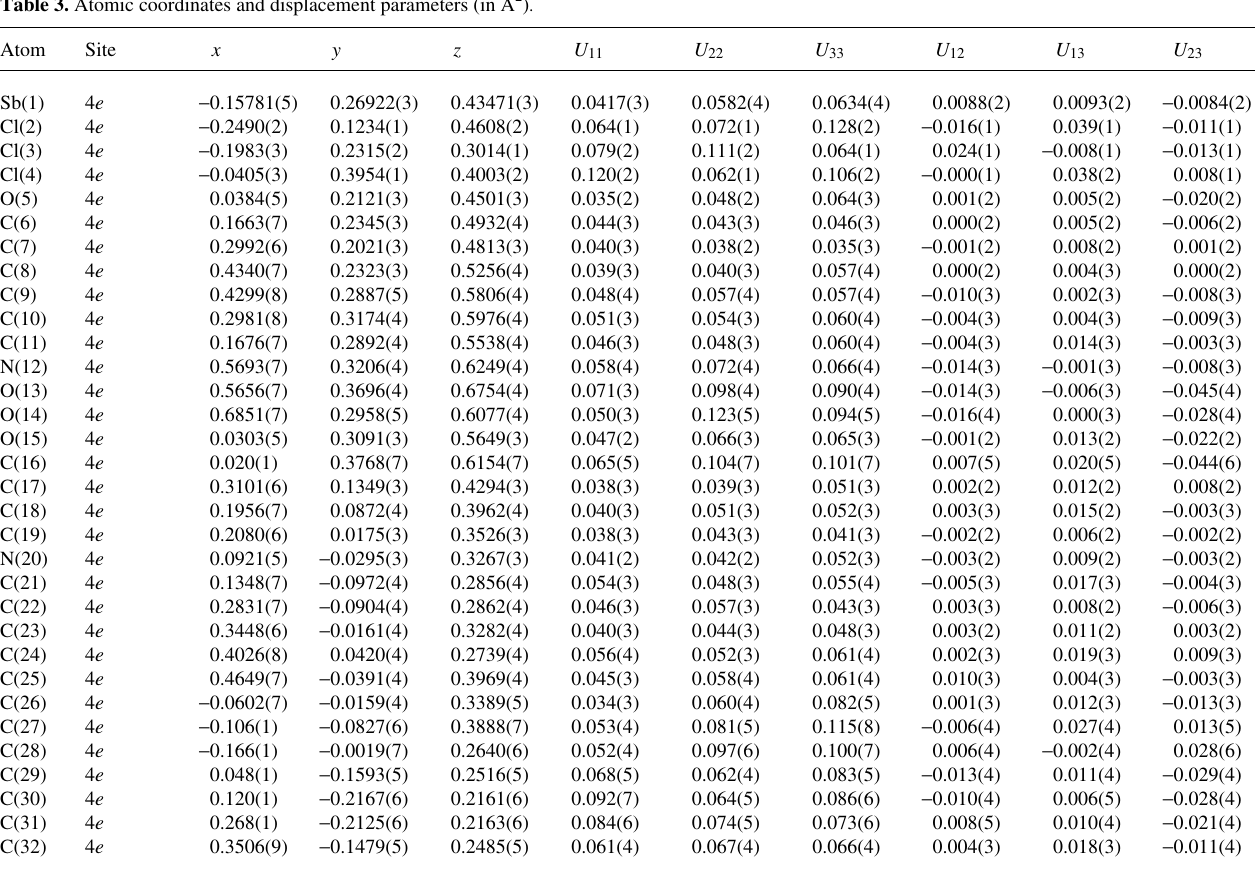
Table 3. Atomic coordinates and displacement parameters (in Å 2 )